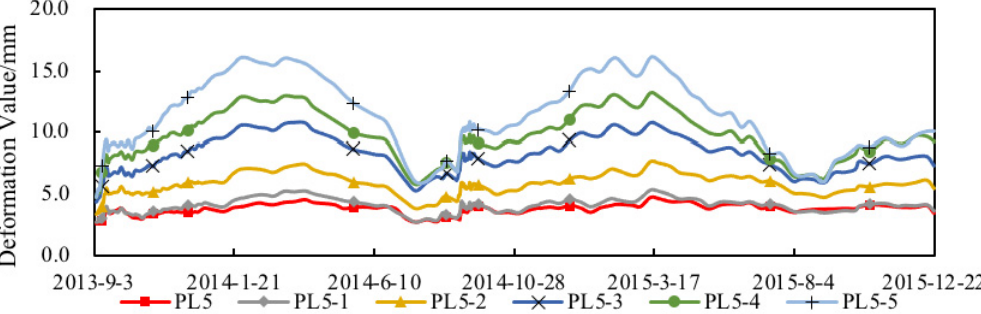
Figure 7. Horizontal displacement process line of positive vertical line of dam sluice section.